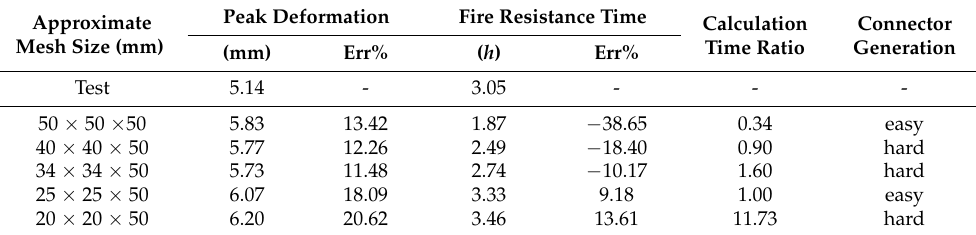
Table 2. Parametric analysis of mesh